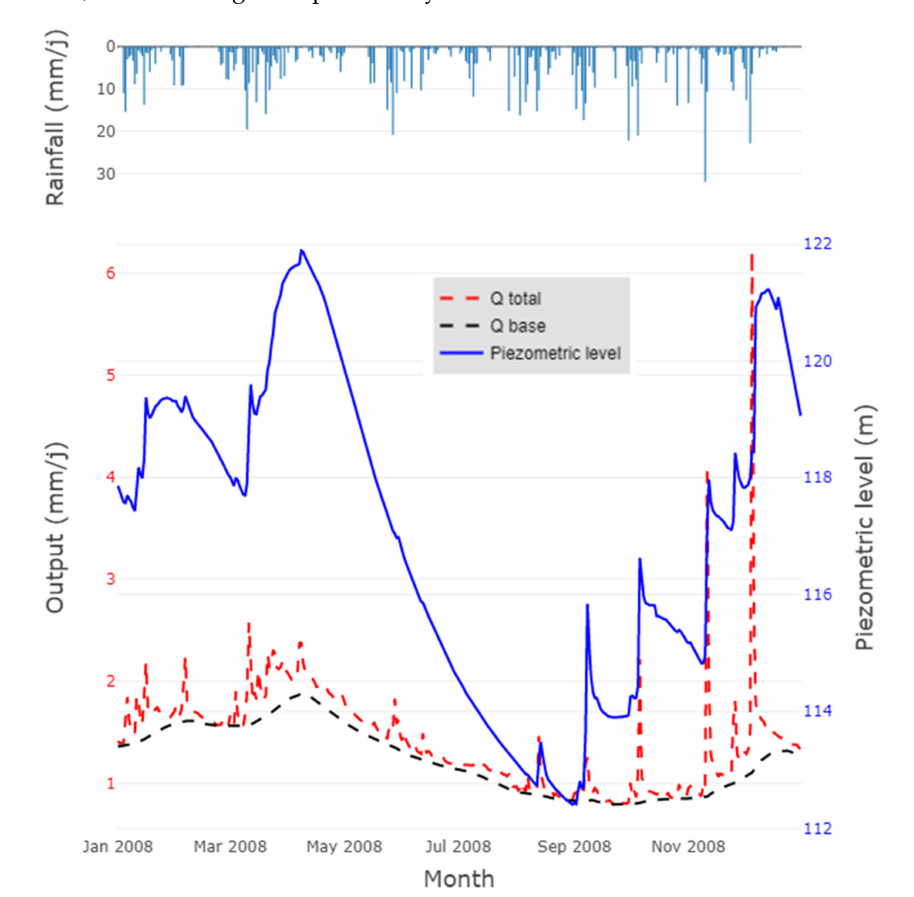
Figure 2. Example of hydrogram separation for the Aa watershed in 2008, and other available